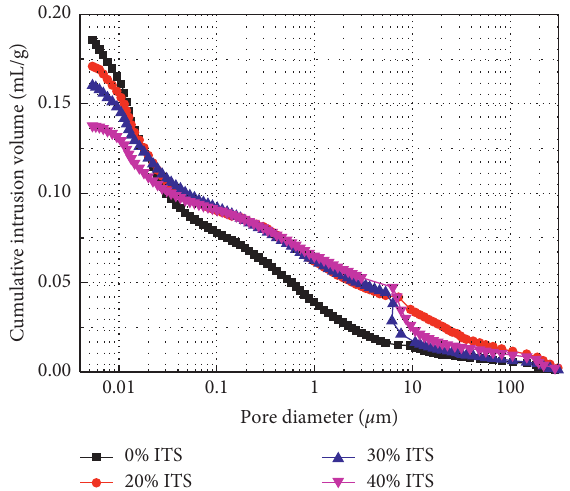
Figure 12: Relationship between cumulative pore volume and aperture.